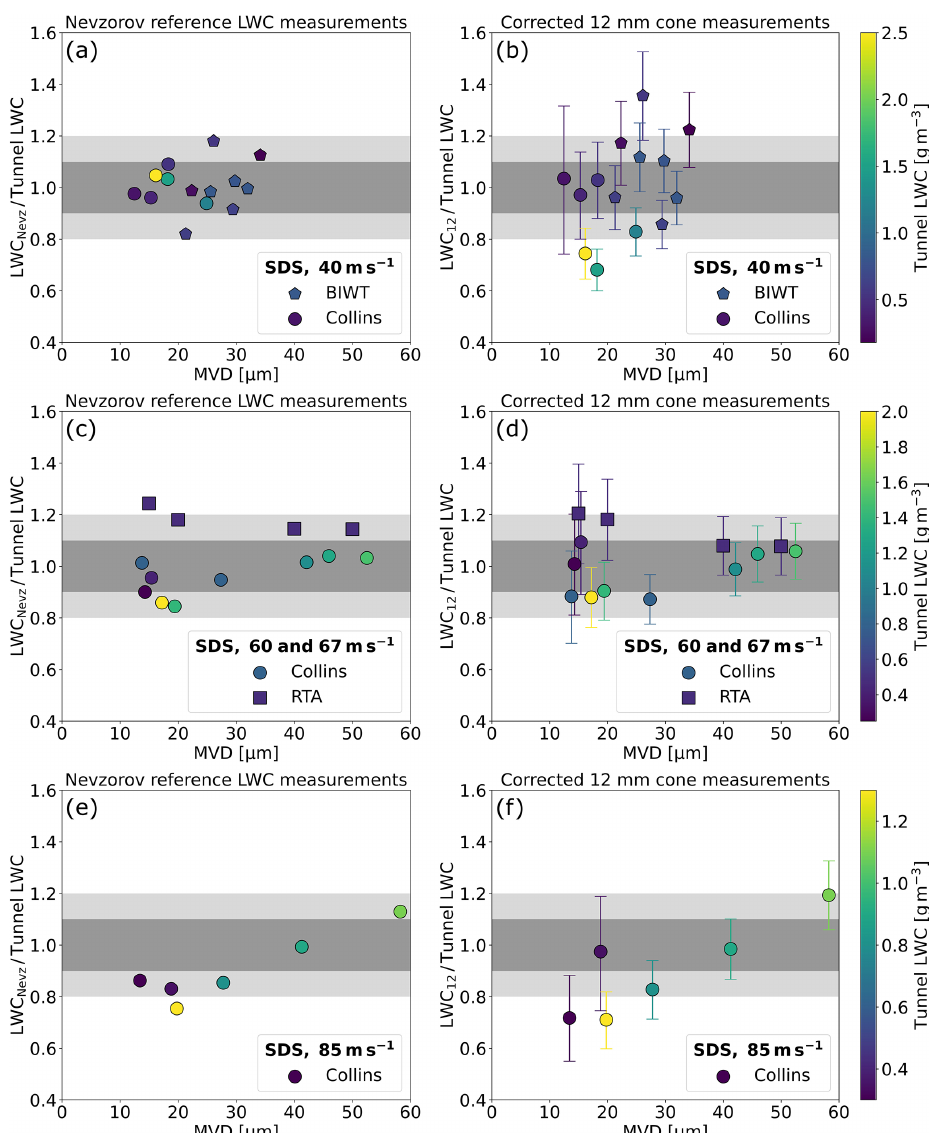
Figure 6. Comparison of the Nevzorov reference LWC and the corrected 12mm cone LWC to the tunnel LWC for the three different airspeed groups. The error bars incorporate all uncertainty sources of the Nevzorov probe as detailed in Appendix A, including the uncertainty in the collision efficiency curve that is described by the standard deviation of D 0 (see Table 5). The error bars do not consider uncertainties not related to the Nevzorov probe, e.g., the IWT